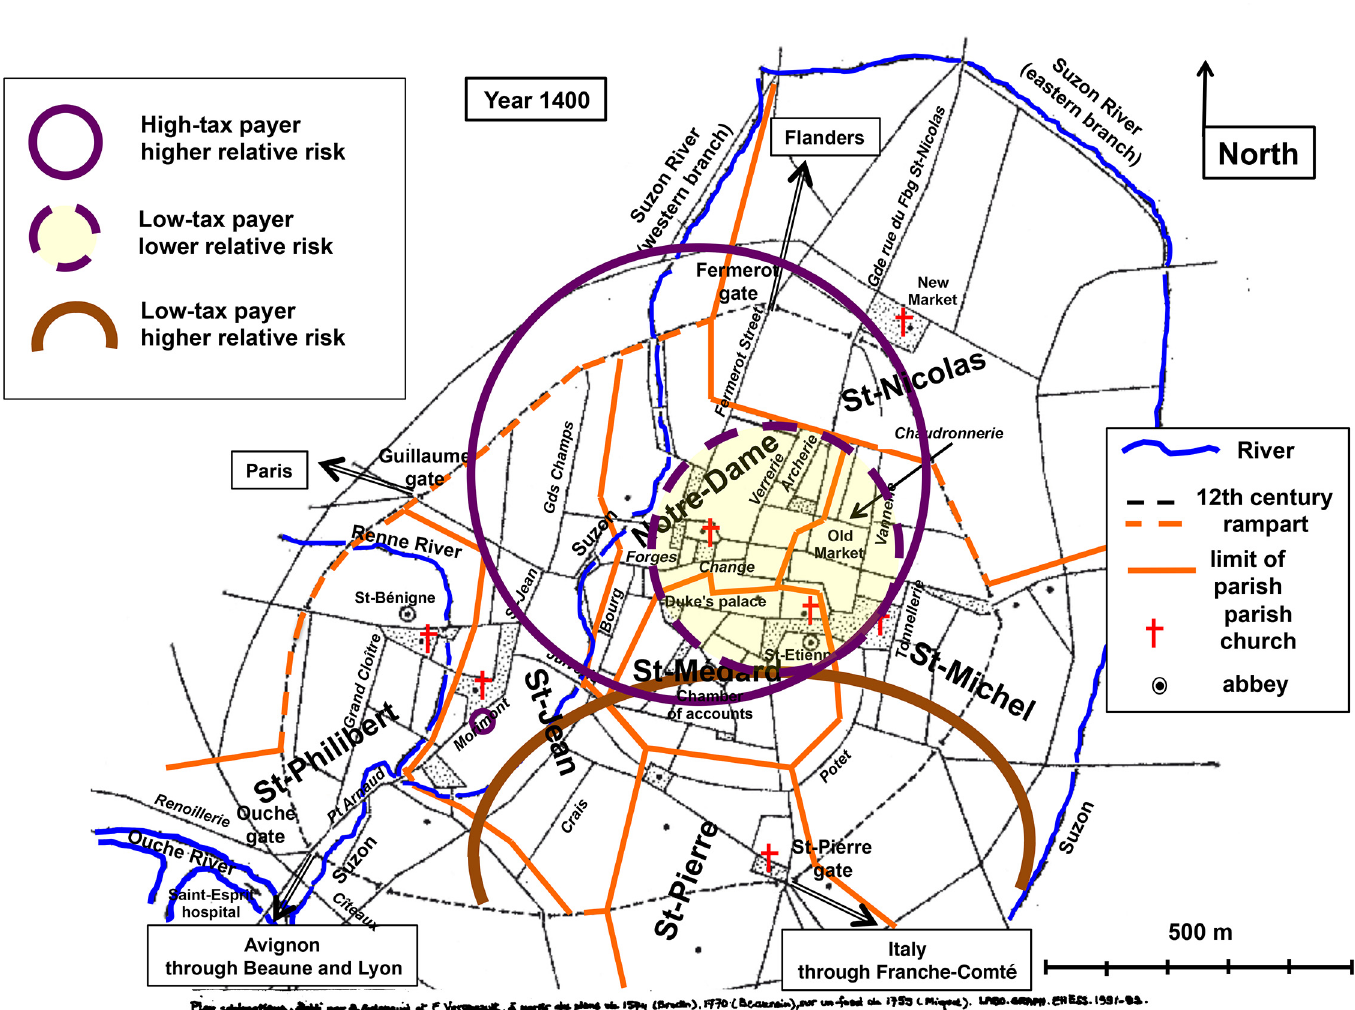
Fig 1. Socio-economic cartography of late medieval Dijon. Georeferenced map of medieval Dijon. Rivers as blue lines. Parish churches, abbeys and a number of prominent places are indicated. Major gates and routes are indicated. The streets mentioned in the text are italicized. The 12th century rampart is shown by dotted lines. Limits of the 7 parishes are in orange solid lines (dotted lines when they coincide with the rampart). Empty areas circled in solid purple line: clusters where high-tax payers were in excess (clusters 1 & 3). Yellow area circled in dotted purple line: cluster where low-tax payers were less numerous (cluster 2). Brown solid line: upper limit of the cluster where low-tax payers were in excess (cluster 4).